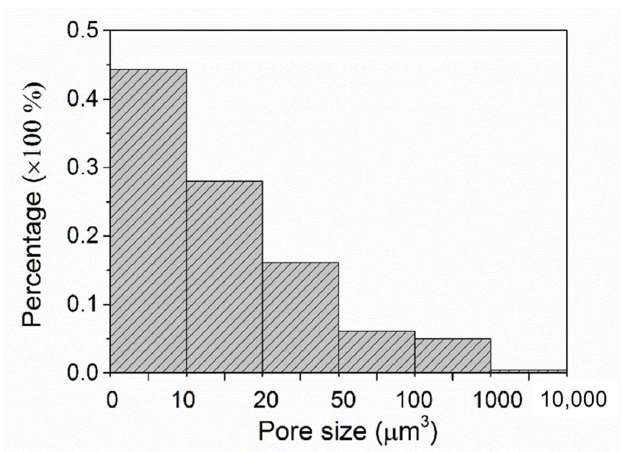
Figure 7. Pores size distribution of cold sprayed stainless steel coating.